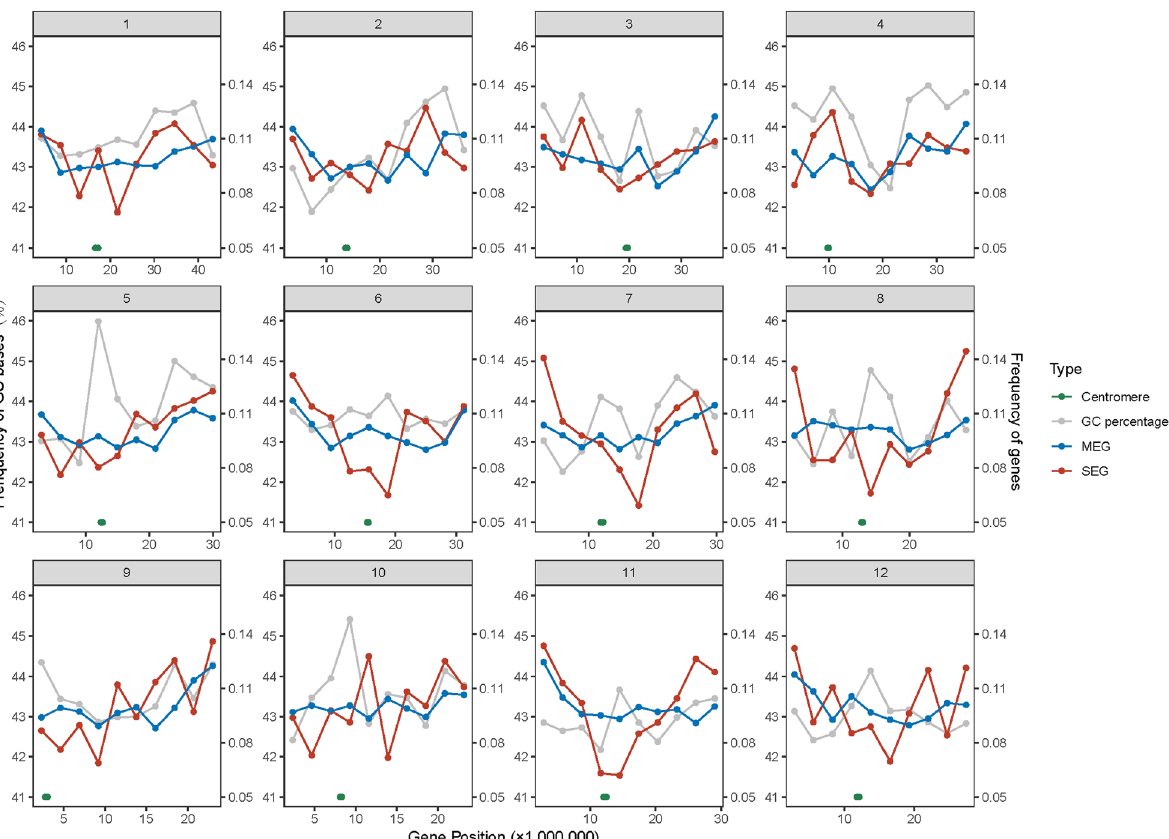
Fig. 3 Distribution of single-exon genes, multiple-exon genes and GC content along each of the twelve chromosomes in rice. Each of the chromosome is divided into ten equal sequence regions. The percentage of GC content, and the numbers of single-exon genes and multiple-exon genes are calculated and counted